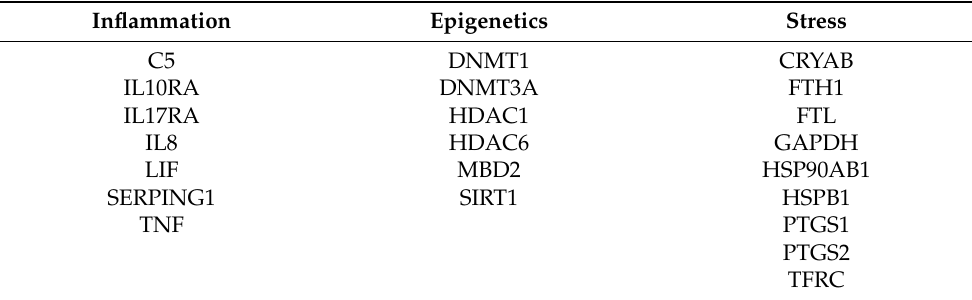
Table 1. List of empirically selected transcripts by molecular functional